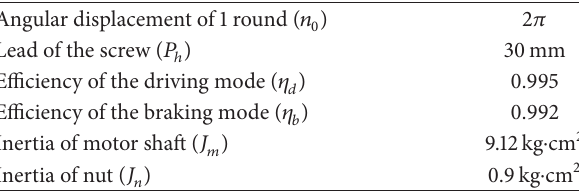
Table 2: Parameters of ball screw type